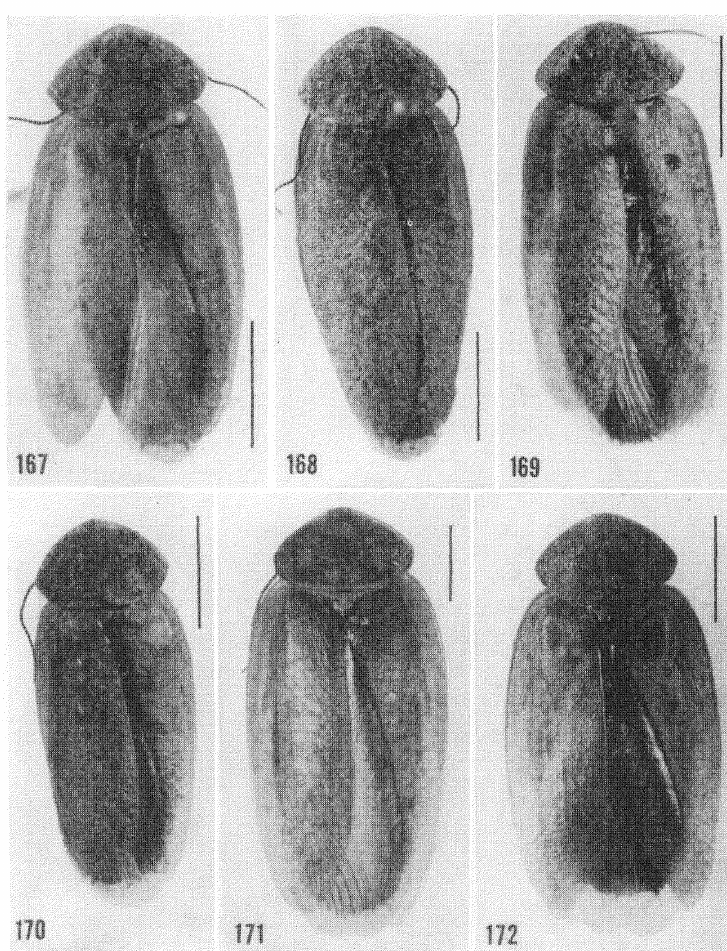
Figures 167-172. Adult males ot? Derocalymma spp. 167. (38 CUZM). D. rajiformis Rehn. Kenya (det. Princis). 168. (1410 L). D. cruralis (Stl). Bipindi, South Cameroon (det. Princis). 169. (1412 L). D. ersi- color Burmeister. Southern Rhodesia (det. Princis). 170. (1417 L). D. costata Rehn. Cameroon (det. Princis). 171. (1409 L). D. pluteus Rehn. Haut-Luapula, Kansenia (det. Princis). 172. (1418 L). D. scruposa scru- posa Rehn. Togo, Misah6hi-Mitte (det. Princis). (scale---